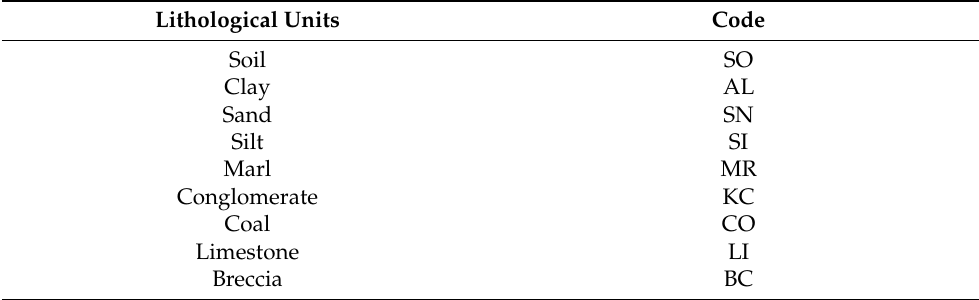
Table 1. Lithological units that correspond in the borehole database. Lithological Units Code Soil SO Clay AL Sand SN Silt SI Marl MR Conglomerate KC Coal CO Limestone LI Breccia